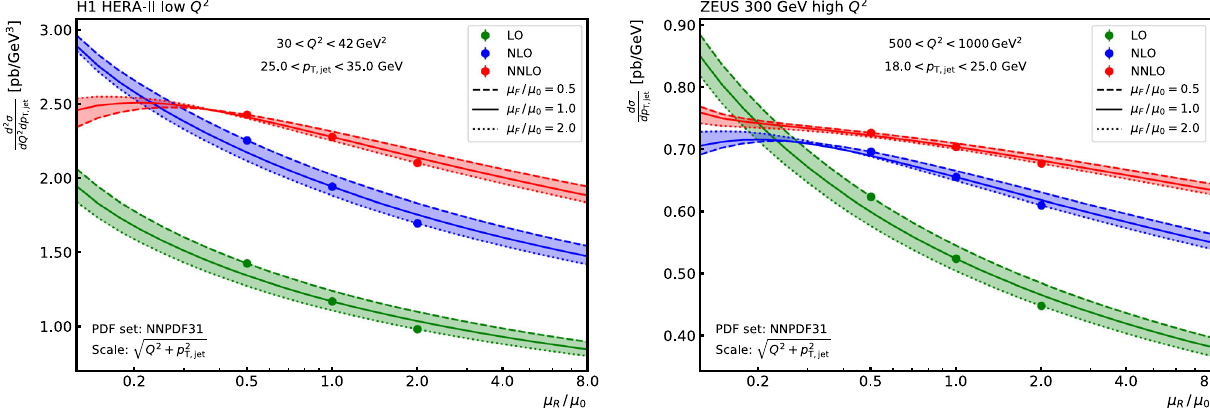
tion scale μ F by factors between 0.5 and 2.0 with respect to the nominal scale. At each order three points indicate the result of symmetric vari- ations of μ R and μ